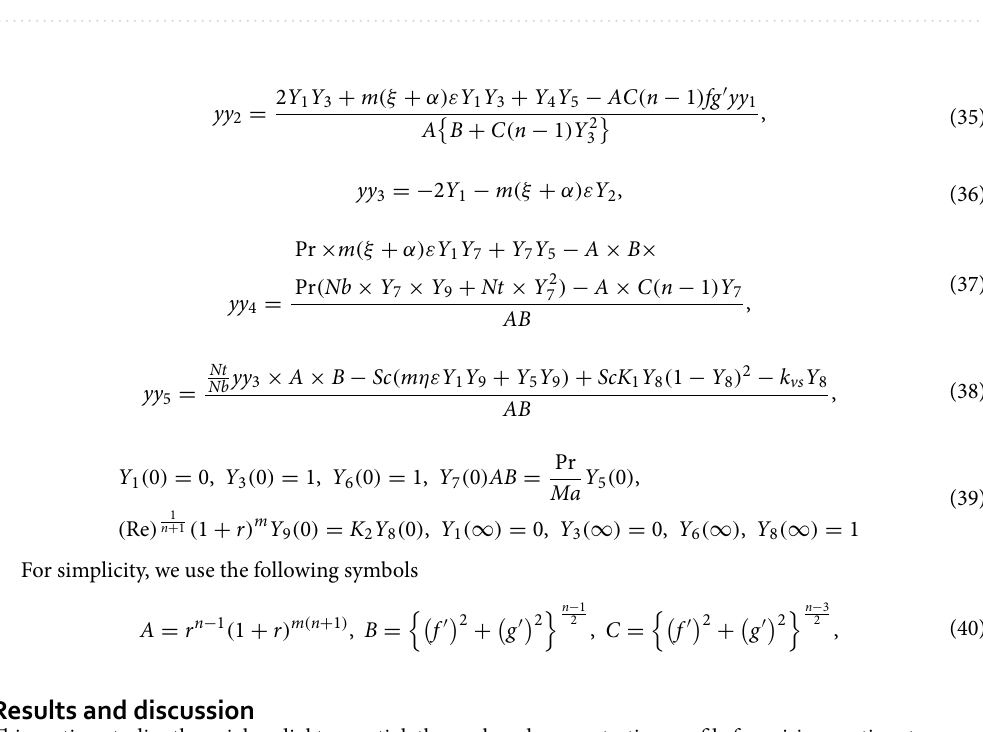
Figure 2. The Radial velocity profile for decreasing power-law fluid index with thickness index m = 0.8, r = 0.6, Pr = 1 of a